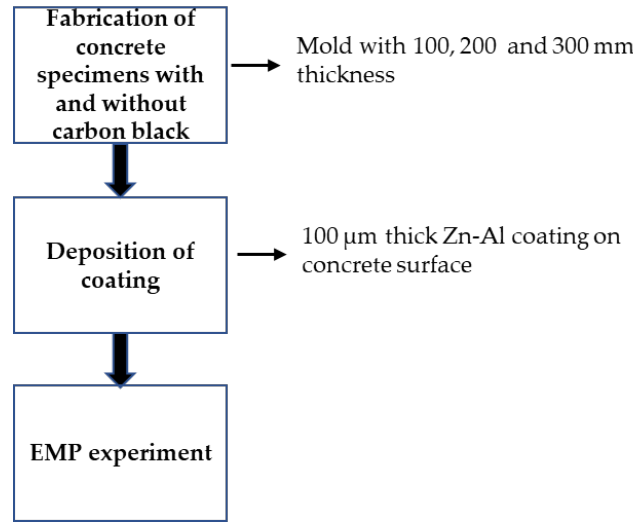
Figure 1. Schematic of experimental procedure.